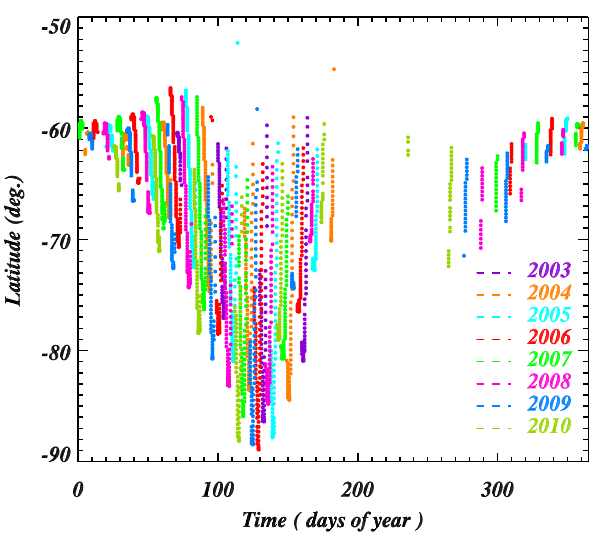
Fig. 2. SCIAMACHY lunar occultation latitudinal distribution for the years 2003–2010; each year the latitudes vary considerably be- tween 59 ◦ S–89 ◦ S.